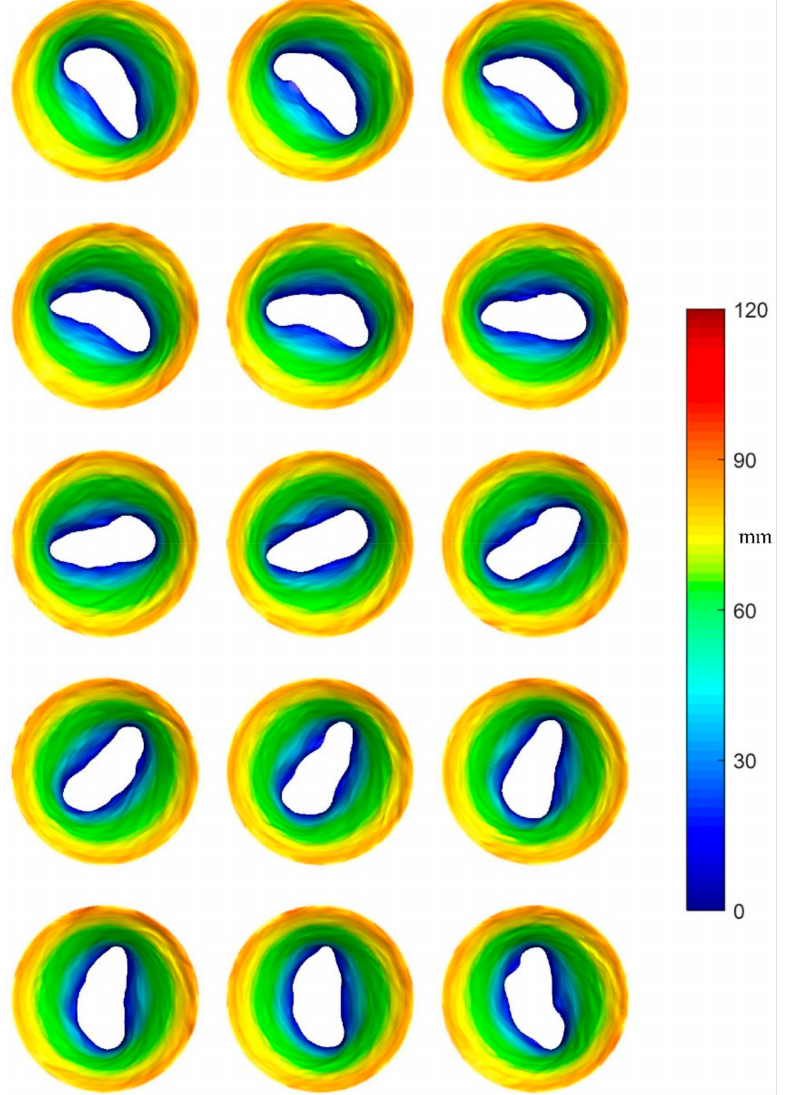
Figure 4. Top view of the free surface height above rotating disk for 3.4 Hz, from top left to bottom right, equally spaced within about 14 s of